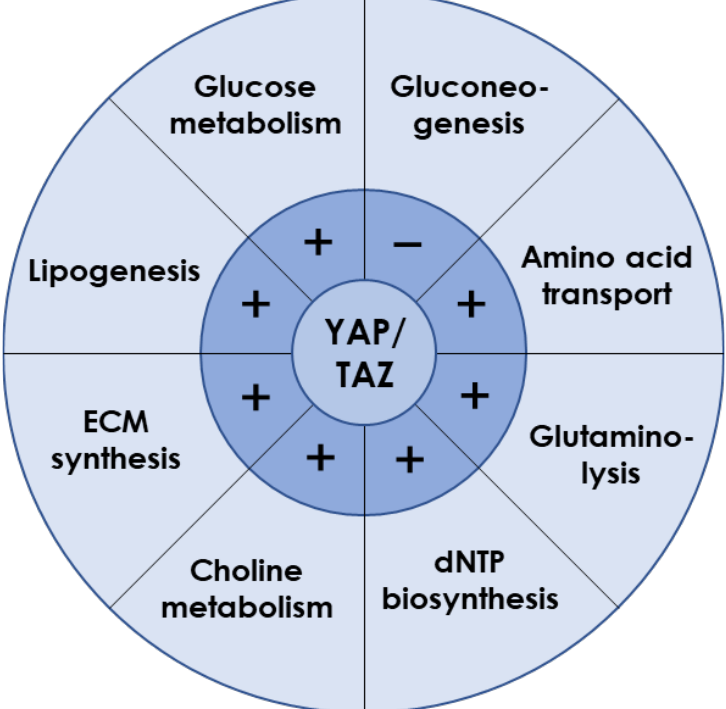
Figure 2. Liver metabolism regulated by YAP/TAZ. YAP/TAZ is required for the expression of key transporters or enzymes involved in various metabolic processes. Those plus and minus signs indicate the positive and negative regulation, respectively.